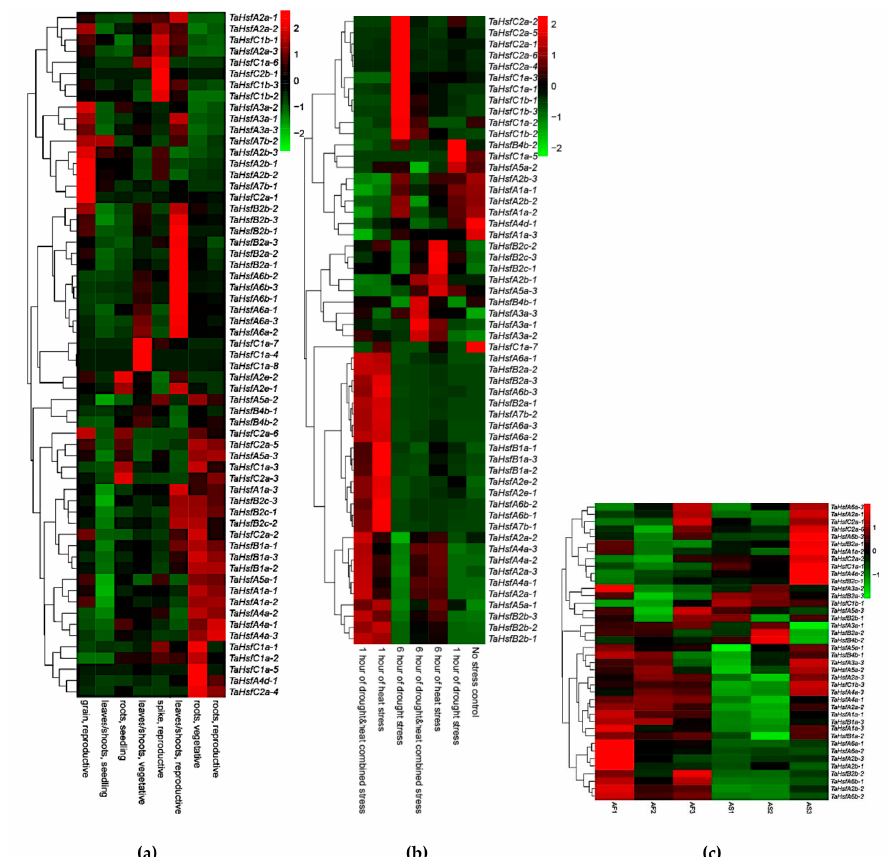
Figure 7. Expression profiles for TaHsfs in di ff erent conditions. ( a ) Heat map of TaHsfs in nine di ff erent tissues and growth stages under normal conditions. ( b ) Heat map of TaHsfs under five di ff erent abiotic stress conditions and in a normal control. ( c ) Heat map of TaHsfs in the thermosensitive male sterile wheat KTM3315A at two di ff erent temperatures. Heatmap obtained using the count values from RNA-seq analysis.